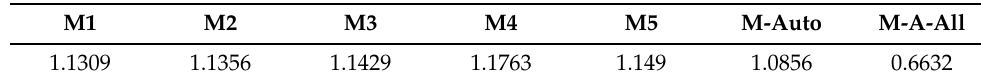
Table 6. Impact of different metagraphs in Amazon